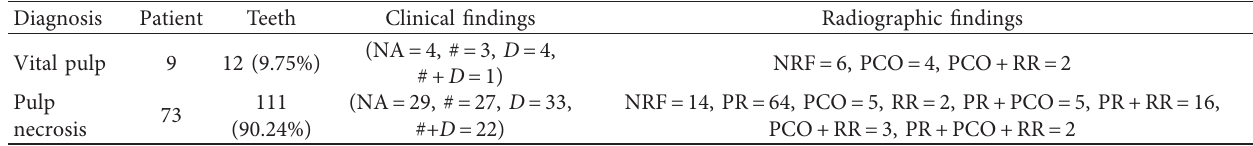
Table 4: Distribution of pulpal